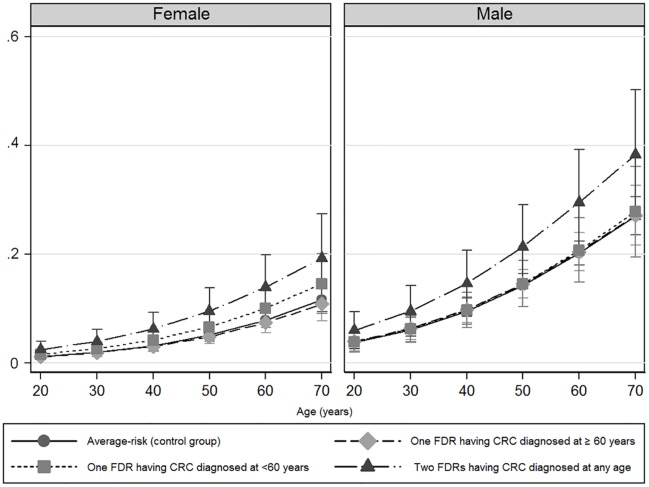
Predicted probabilities of advanced colorectal neoplasia according to age and gender.Women (left) and men (right). A logistic regression model was developed to predict the probability of advanced neoplasia according to age. The observed frequencies and probabilities predicted from the regression equation were graphically represented, stratifying individuals in 10-y subsets (from 20 to 70 y for the affected familial groups, and from 50 to 70 y for the control group). Vertical lines mark the corresponding 95% confidence intervals.